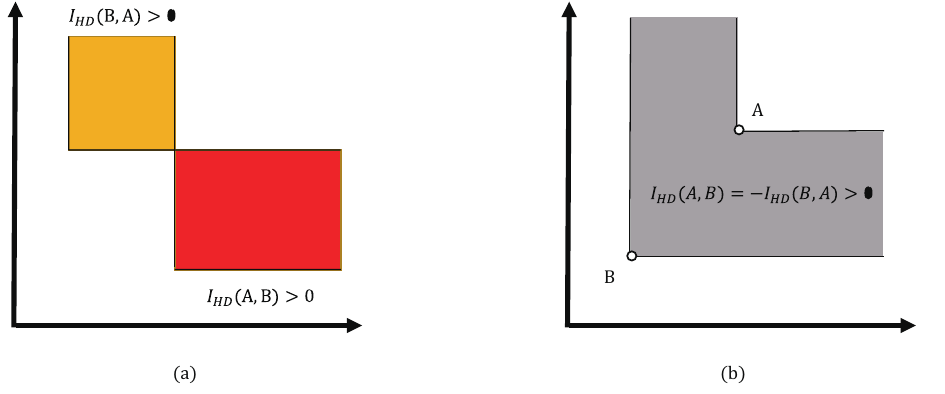
Figure 10. The illustrations of I HD indicator. In ( a ), when the individuals in the set A and the individuals in the set B are not dominated by each other, the yellow and red parts on the left indicate the areas of the independently dominated regions of A and B, respectively. In ( b ), when A is dominated by B, the gray part of the figure indicates the area of the independently dominated region of B. This figure is adopted from